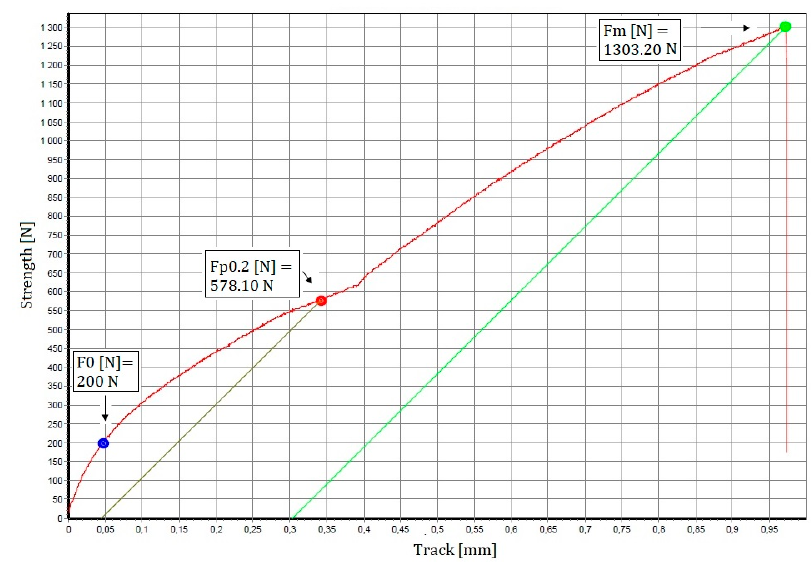
Figure 13. Tensile strength curve of an experimental solder alloy.